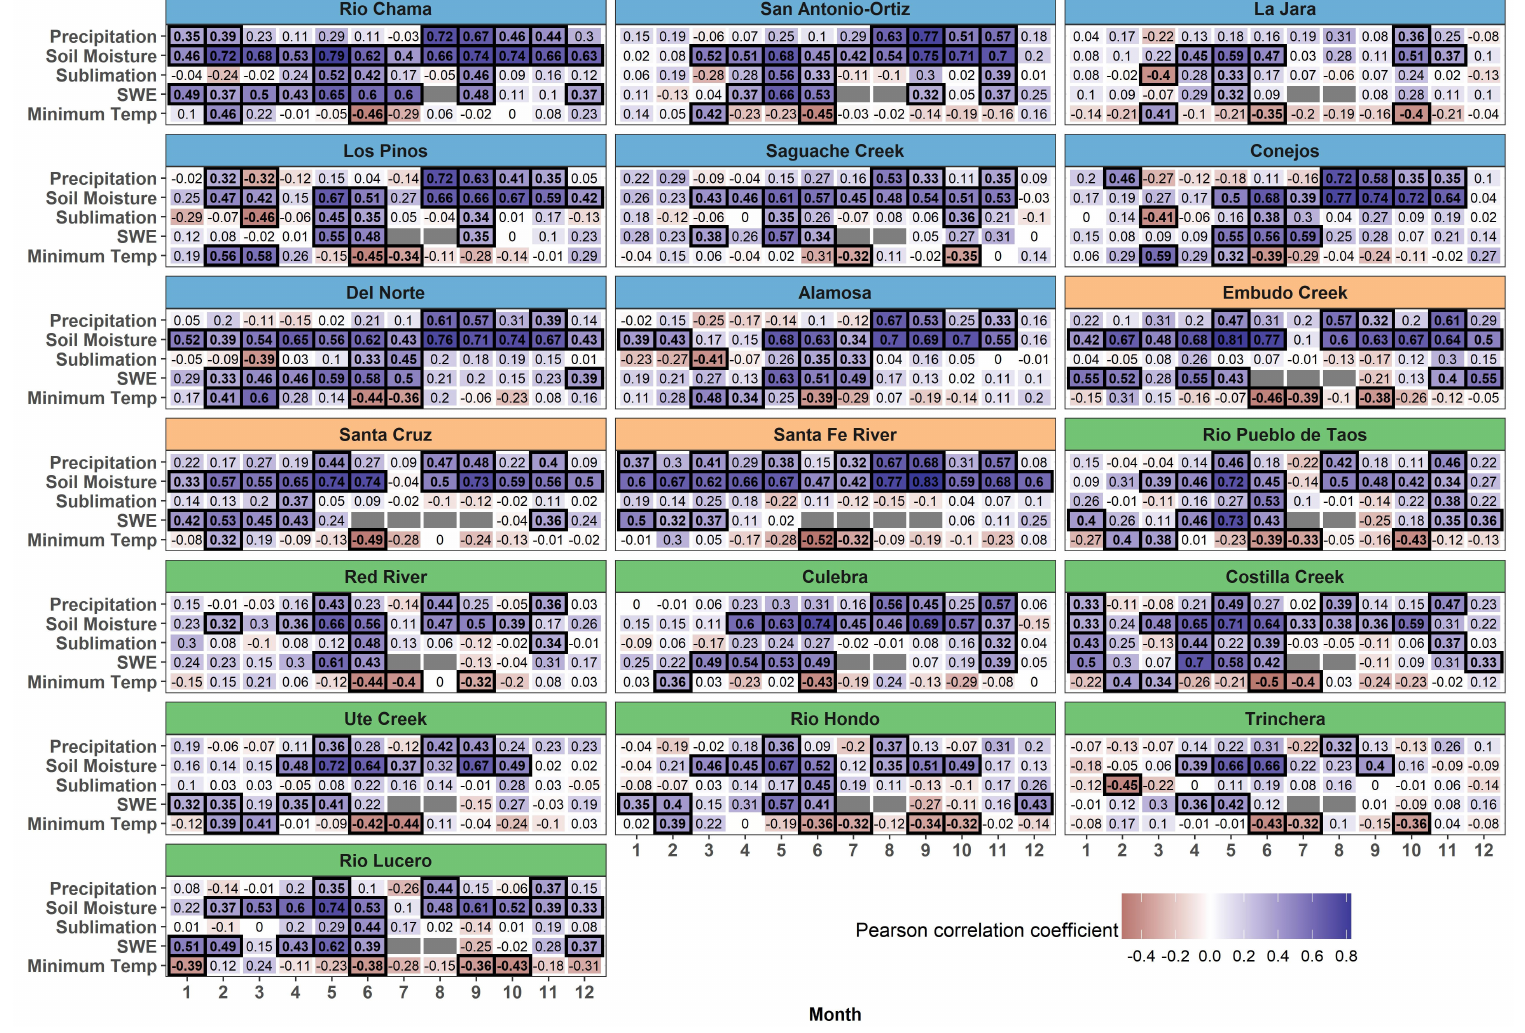
Figure A4. Monthly correlation by sub watersheds of the URG